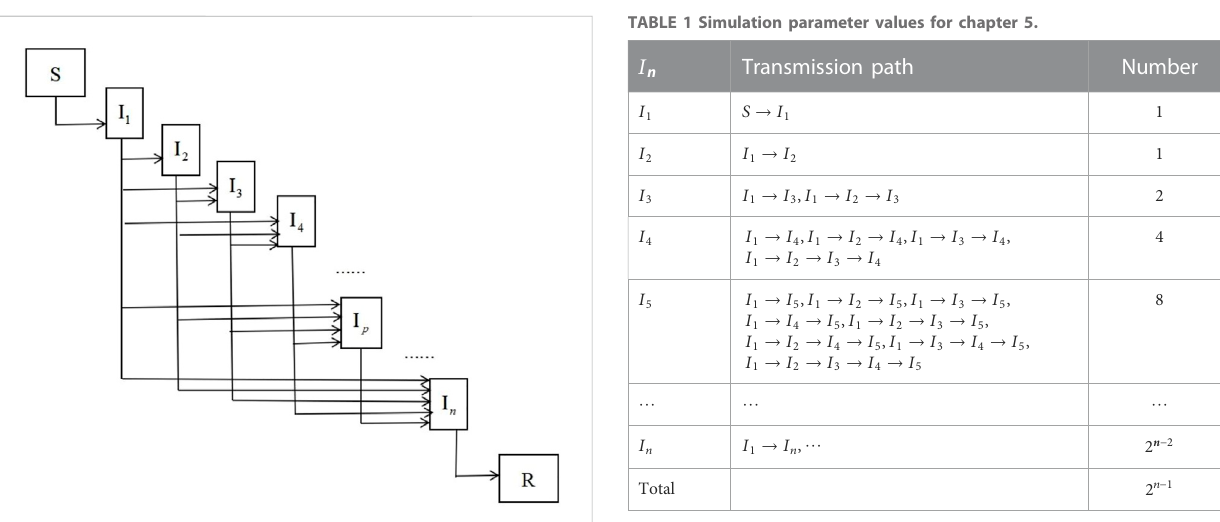
FIGURE 1 Disease transmission paths.